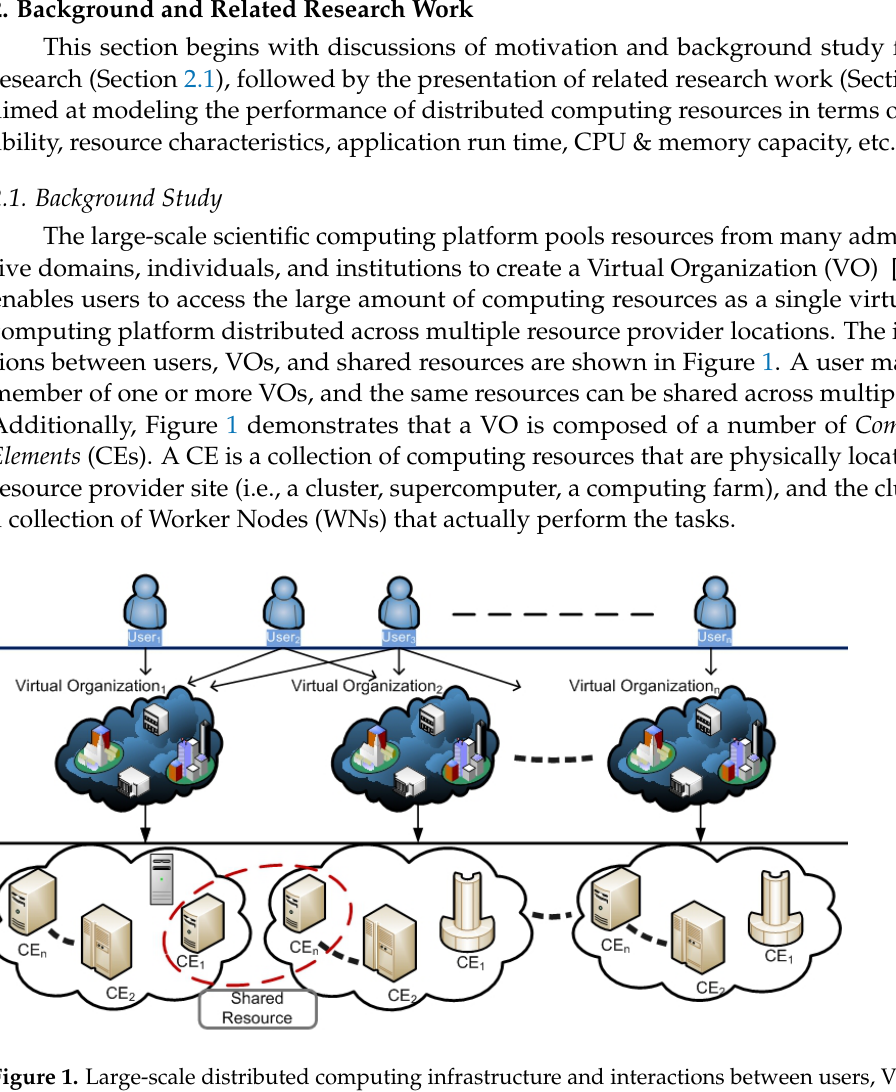
Figure 1. Large-scale distributed computing infrastructure and interactions between users, VOs, and resource